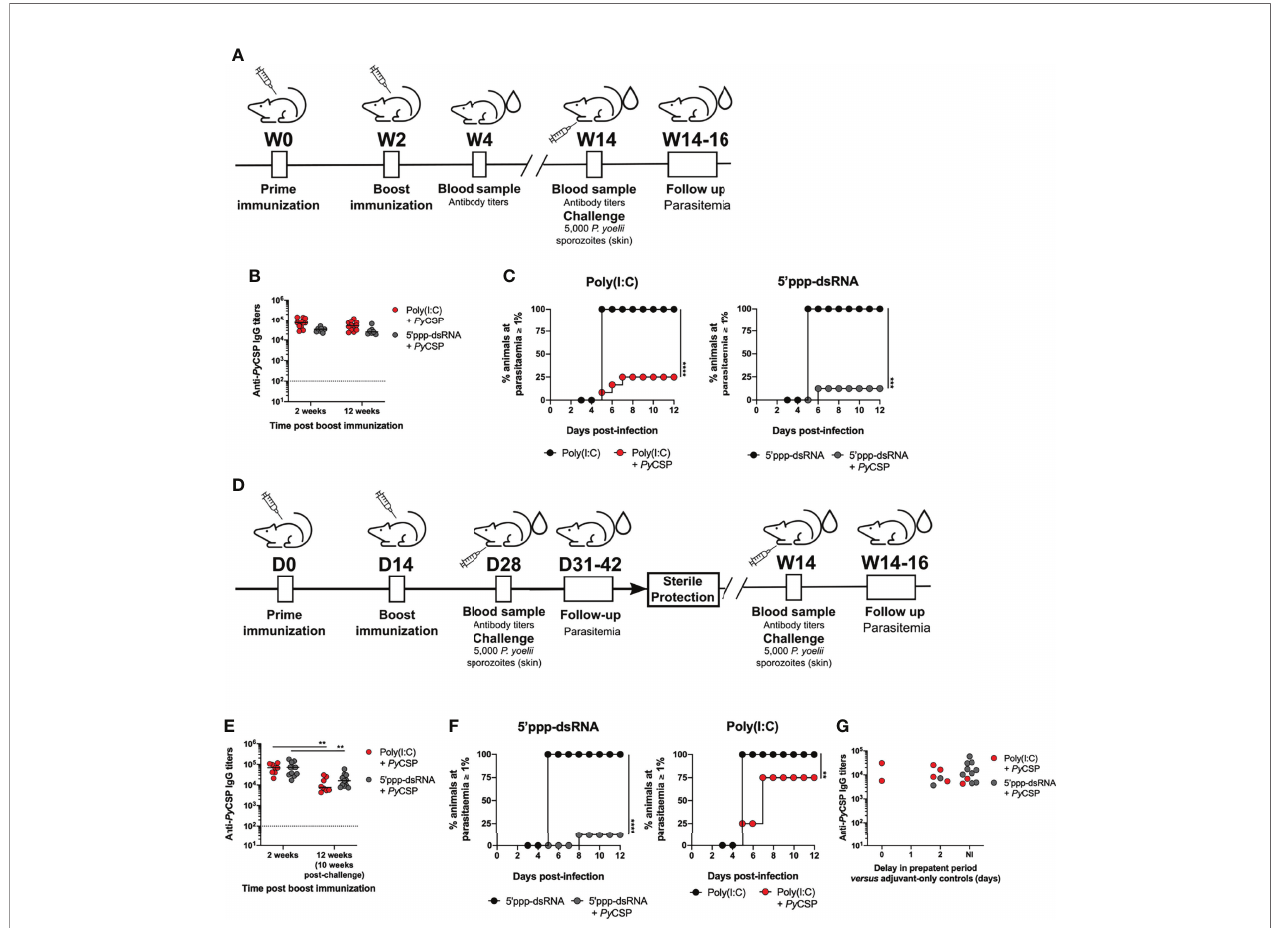
FIGURE 5 | Long-term protection conferred by immunization with Py CSP in combination with poly(I:C) and 5 ’ ppp-dsRNA. (A) Immunization strategy and challenge conditions. (B – D) Long-term protection to a skin challenge in control mice (n = 8) and mice immunized with Py CSP in combination with poly(I:C) (n = 8, two independent experiments) or 5 ’ ppp-dsRNA (n=8, two independent experiments), 12 weeks post booster immunization. (B) Total anti -Py CSP IgG titers 2 and 12 weeks post booster immunization in immunized mice. Symbols represent individual values and black lines the mean for each group. Dotted line represents the minimal detectable titers. (C) Incidence of blood stage infection in control and immunized animals. (D) Immunized mice which survived a fi rst sporozoite challenge 2 weeks after booster immunization were challenged a second time 10 weeks later. (E, F) Protection against a second skin challenge in mice immunized with Py CSP in combination with poly(I:C) (n = 7, two independent experiments) or 5 ’ ppp-dsRNA (n = 11, two independent experiments). (E) Total anti -Py CSP total IgG titers 2 and 12 weeks post booster immunization (10 weeks after fi rst challenge) in immunized mice. Symbols represent individual values and black lines the mean for each group. Dotted line represents the minimal detectable titer. (F) Incidence of blood stage infection in control and immunized animals. (G) Total anti- Py CSP IgG titers versus the delay in prepatent period, in days, in immunized re-challenged mice. Statistical signi fi cance was determined using two-way ANOVA with Tukey ’ s multiple comparisons test (B and E). Survival curves were plotted using Kaplan-Meier plot and statistical signi fi cance was determined using the Log-Rank (Mantel-Cox) test (C and F). **p ≤ 0.01; ***p ≤ 0.001; ****p ≤